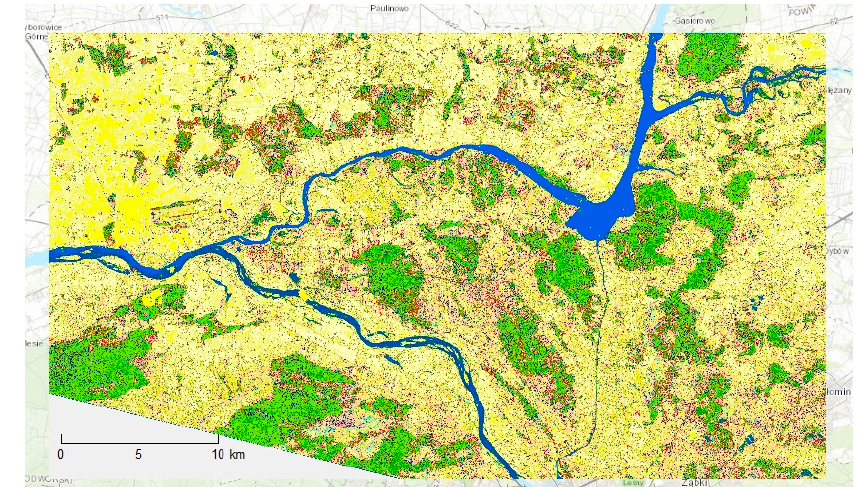
Figure 7. Visualization of the resulting transformation image using k-mean clustering of 24 LU/LC classes. The colors are similar to the CLC legend. Displayed as a layer on top of a topographic map.